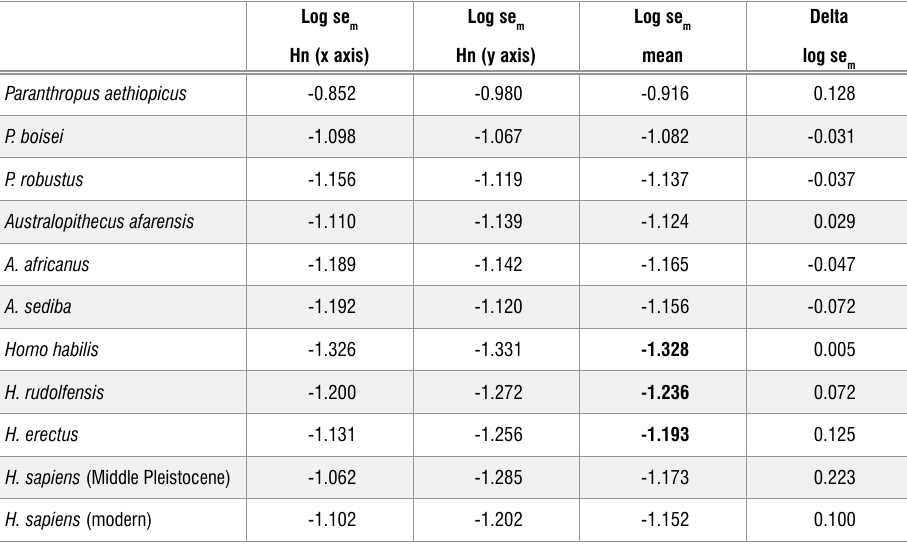
Results of pairwise comparisons between cranial measurements of Homo naledi and corresponding measurements of other